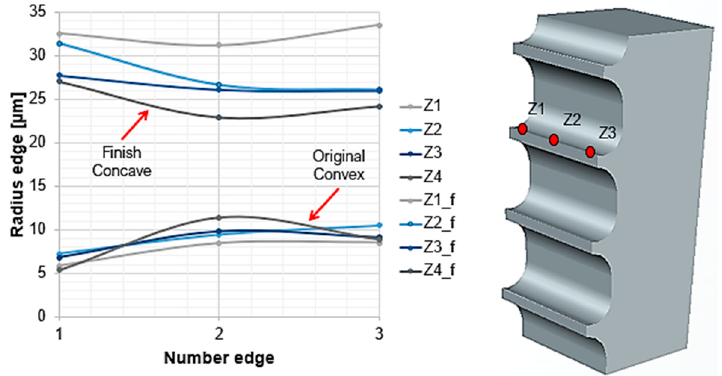
Figure 6. Cutting edge radius measurement at three different points along the cutting edge.